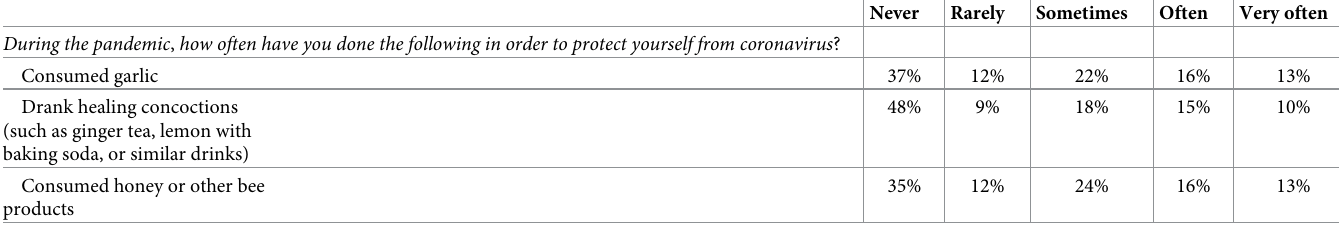
Table 6. Distribution of answers on the frequency of use of pseudoscientific practices—Study